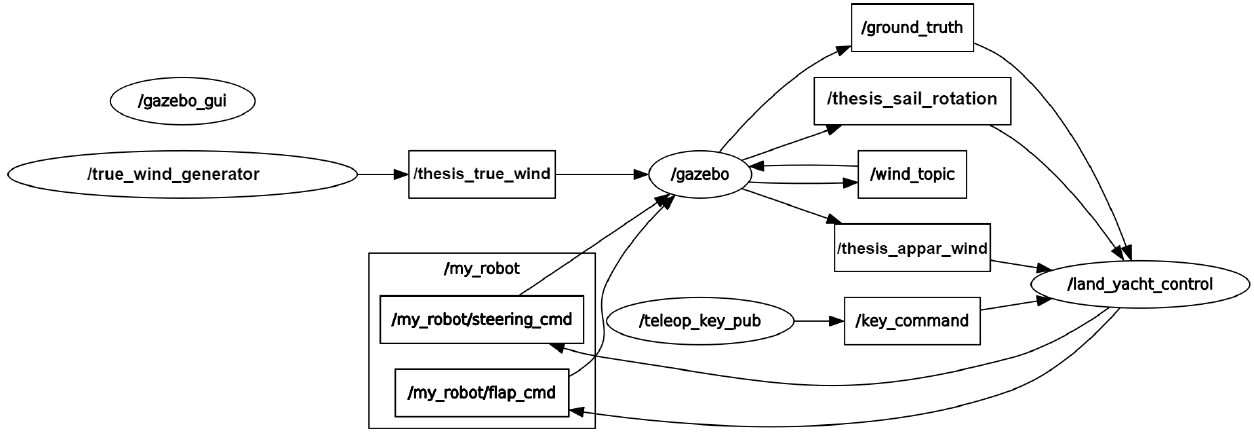
Figure 8. Experimental